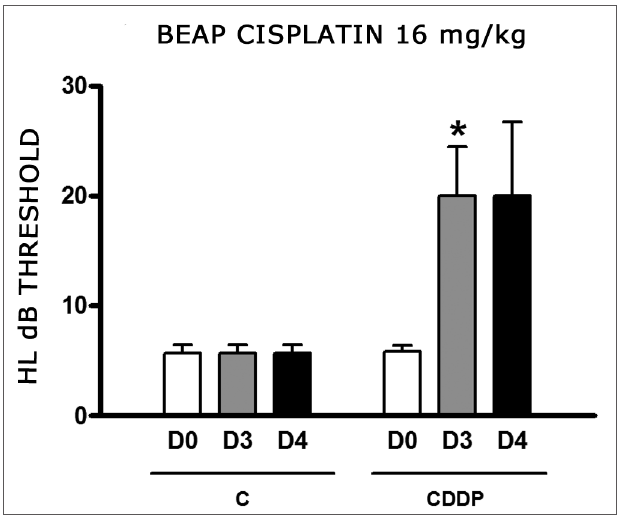
Figure 7. Graph of the mean electrophysiological thresholds in groups 11 and 12 at D0, D3 and D4, expressed as mean and mean standard error (MED and [IEY2] EPM). The asterisk represents a statistically significant difference. CDDP = cisplatin; C = control. ANOVA - Tukey: * p < 0.05 (D3 x D0 CDDP).